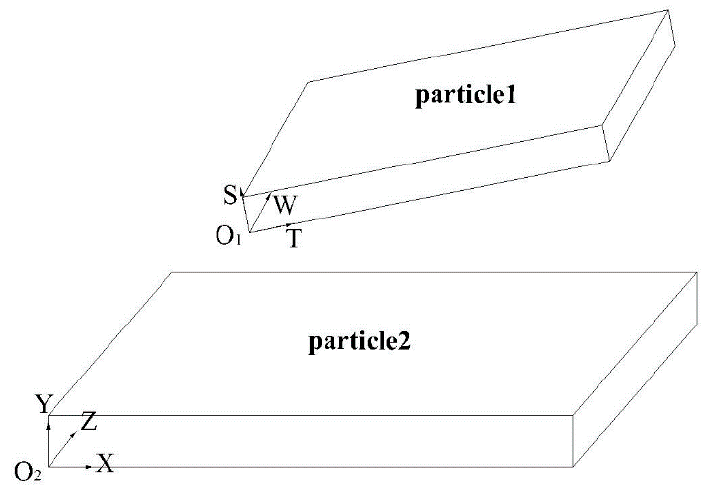
Figure 1. Two arbitrary neighboring platy clay particles.